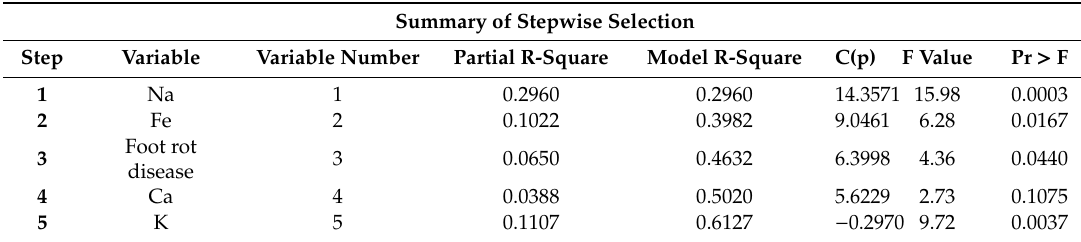
Table 3. Stepwise regression analysis for factors influencing